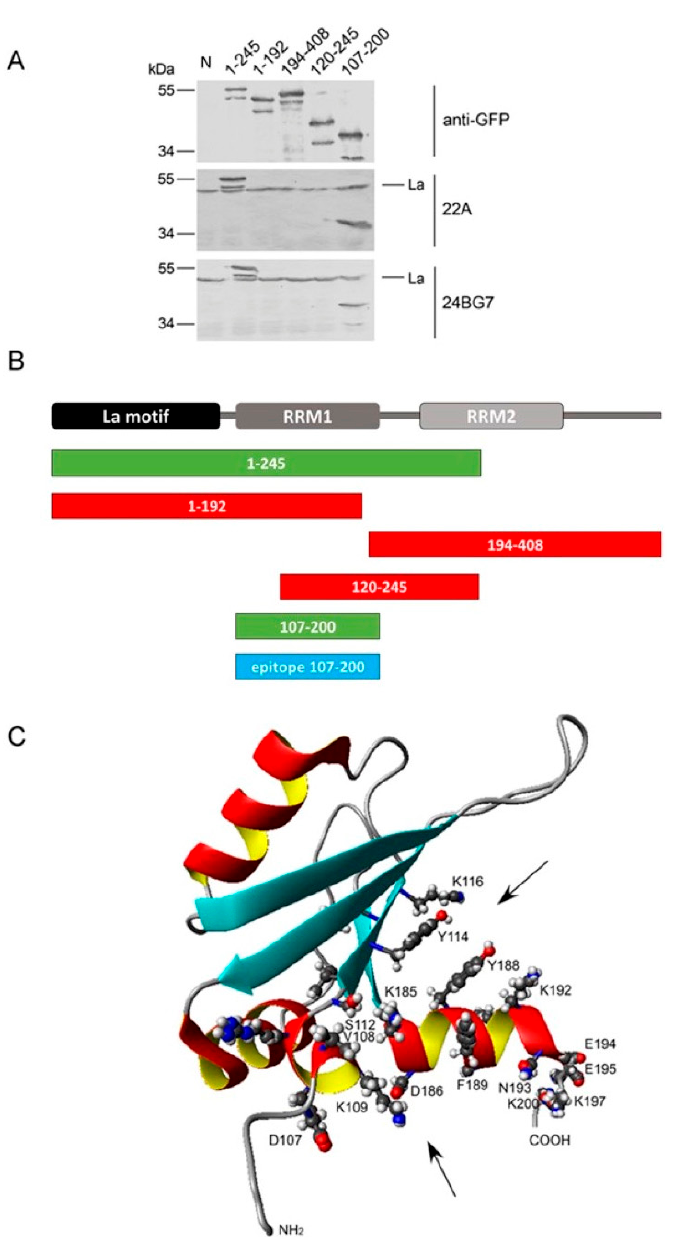
Figure 11. Epitope mapping of the Group 1 anti-La mabs (22A and 24BG7). HeLa cells were transfected with GFP-La fusion constructs encoding N- or C-terminally truncated La fusion proteins. Untransfected HeLa cells served as the negative control (N). ( A ) Total extracts were analyzed by SDS-PAGE and immunoblotting using antibodies against GFP or the anti-La mabs (22A or 24BG7); ( B ) Schematic summary of the selected GFP-La fragments. Immunoreactive GFP-La fusion proteins are highlighted in green. GFP-La fragments which failed to react with anti-La mabs are shown in red. The identified epitope region is highlighted in blue; ( C ) Predicted 3D structure of the RRM1 domain. Epitope mapping locates the epitope(s) recognized by the anti-La mabs (22A and 24BG7) to the RRM1 domain of the La protein. The folding of the RRM1 brings N- and C-terminal helices of the RRM1 in close vicinity, which may help to stabilize the 3D structure of the RRM1. The arrows point to potential conformational epitope regions.